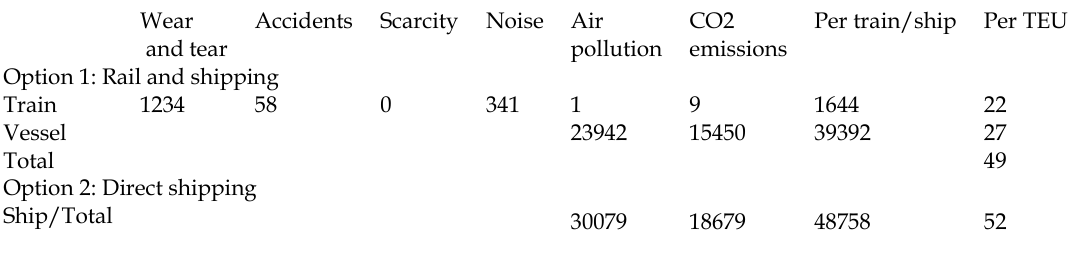
Table 5. Social costs of the two options (in €) based on European guidelines Wear Accidents Scarcity Noise Air CO2 Per Per and pollution emissions train/ship TEU tear Option 1: Rail and shipping Train 124 1784 Vessel 14567 11445 26011 Total 42 Option 2: Direct shipping Ship/Total 18300 13836 32137 34 Source: Ricardo (2014) and own